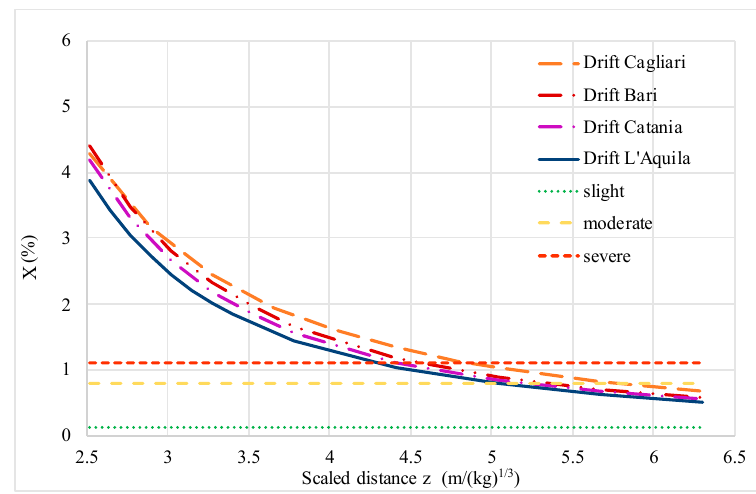
Figure 9. Maximum drift for the structure under blast load for each location, 500 kg TNT.